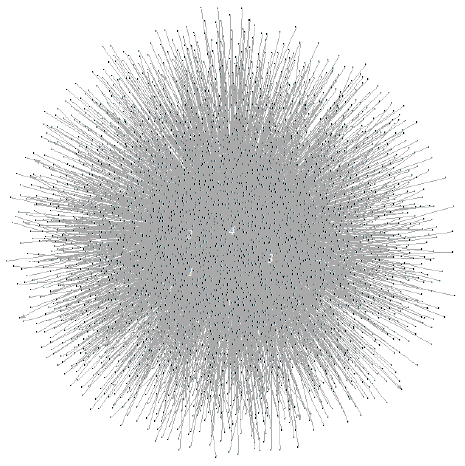
Figure 7. Interbank network formation with a risk-averse policy at α =